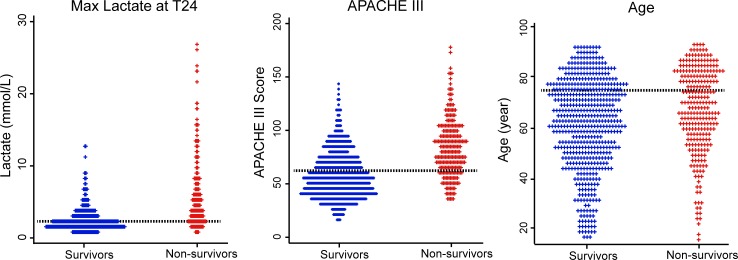
Dot plot for distribution of max lactate at 24h, APACHE III score, and age between survivors (n = 523) and non-survivors (n = 258).The dotted lines indicate cut-off values.